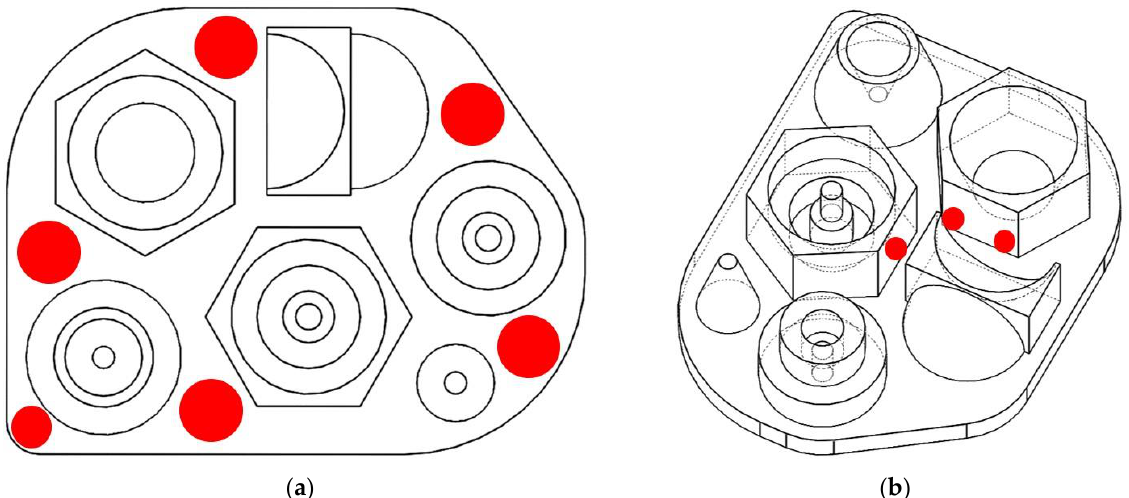
Figure 15. Manual probing points for base alignment are indicated with red areas. ( a ) Top view of points on the base plate; ( b ) a perspective view showing points on HX1 and HX2.